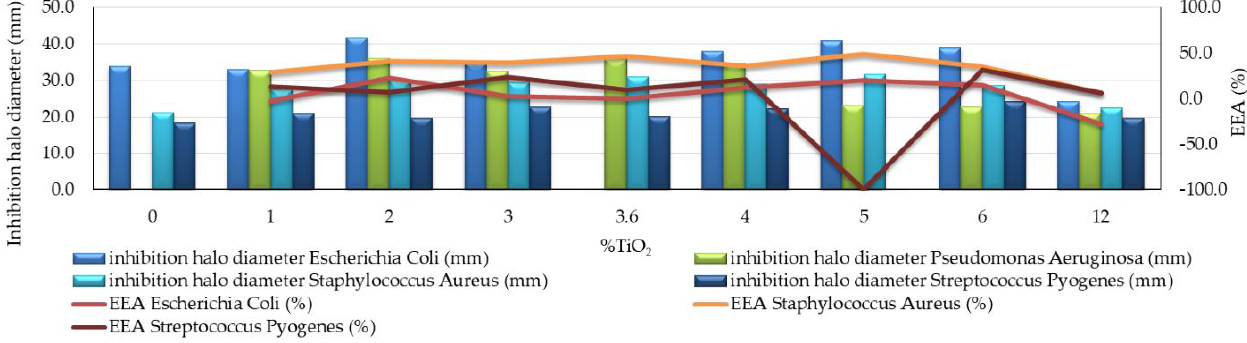
Figure 3. Inhibition halo size development after 2 days of exposure to bacteria Escherichia Coli , Pseudomonas Aeruginosa , Staphylococcus Aureus , and Streptococcus Pyogenes . (In the case of Pseudomonas Aeruginosa contamination, the EEA could not be quantified, because the control sample (0% TiO 2 ) did not show an inhibition halo). EEA: the percentage change in the diameter of the inhibition halo of the analyzed sample, indicating the effectiveness of the antibacterial effect.